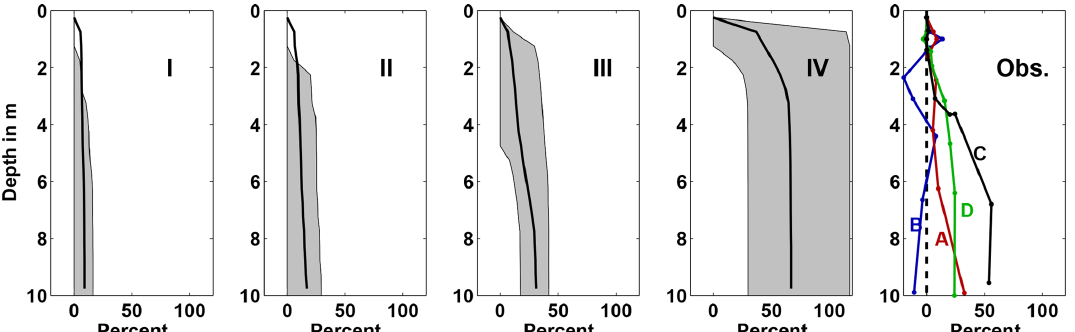
Figure 9. Modeled and observed N 2 O profiles, expressed as relative flux error R (Sect. 2.2.6), i.e., equivalent to overestimation of air–sea gas exchange flux if using N 2 O at depth instead of bulk N 2 O in bulk flux parameterizations. I, II, III, IV: distributions of R in runs of 1-D transport model (Sect. 2.2.7), forced by time series of TLD from respective glider time series, and by ASCAT wind speed. Thin lines/grey shading: 95% limits of temporal distribution of flux overestimation at each depth. Thick lines: mean flux overestimation. OBS: flux overestimation of observed high-resolution profiles at sites A to D.